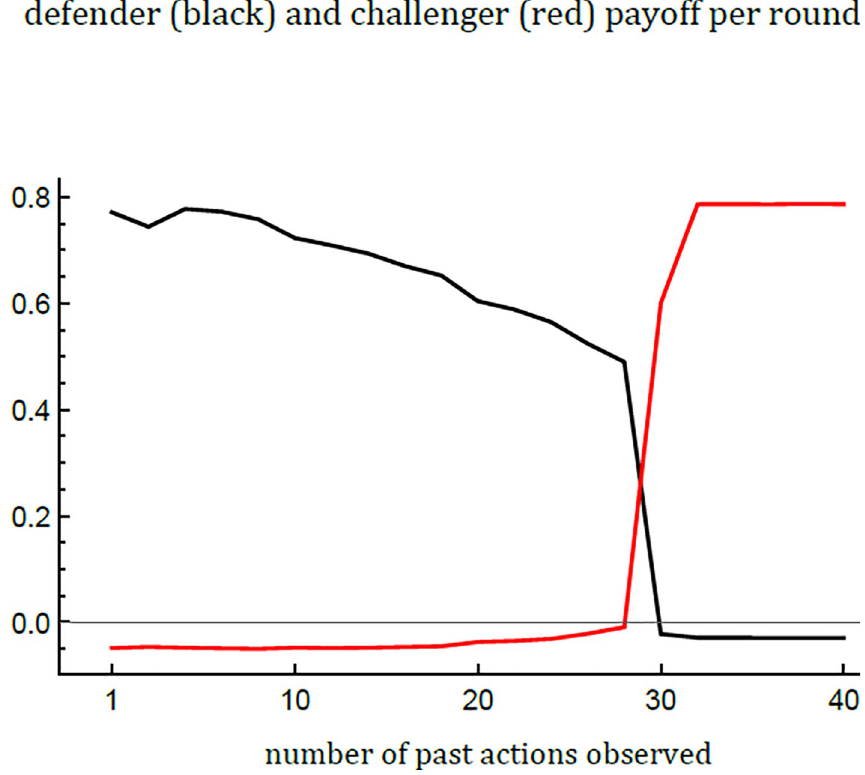
Fig 8. Dependence of average challenger and defender long term payoffs on the number of observations if reputations are determined by empirical fighting frequencies. With only a single observation, the fighting-frequency scheme coincides with the last-action scheme. Defender payoff is high if the number of observations is small and deterrence can evolve. As the number of observations grows, defender payoff slowly declines first and then suddenly drops below zero when deterrence breaks down. For challengers, the situation is reversed. Parameter values: v = 1, c = 1.5, a = 0.1, N = 10 4 , N F = 100, d = 0.9, u = 10 − 2 , μ = � = δ = 10 − 3 . Payoffs are averaged over rounds 8000 − 10000 from 100